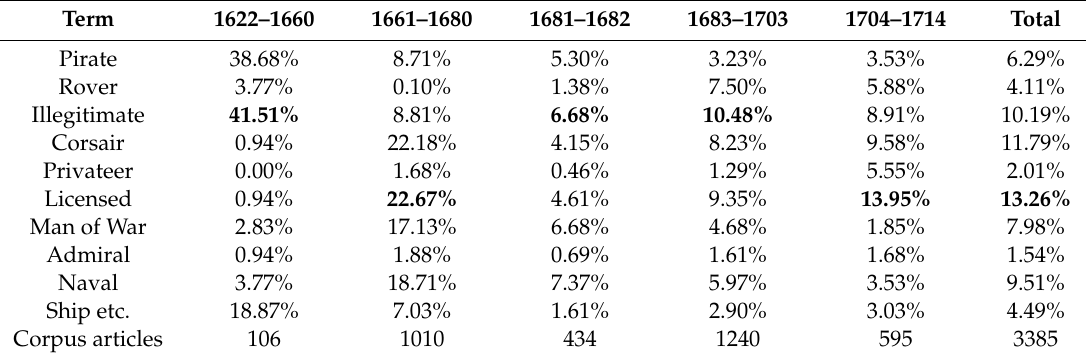
Table 4. Classifications for Maghrebi ships at sea (% of articles employing term within entire corpus, highlighting most common category in each